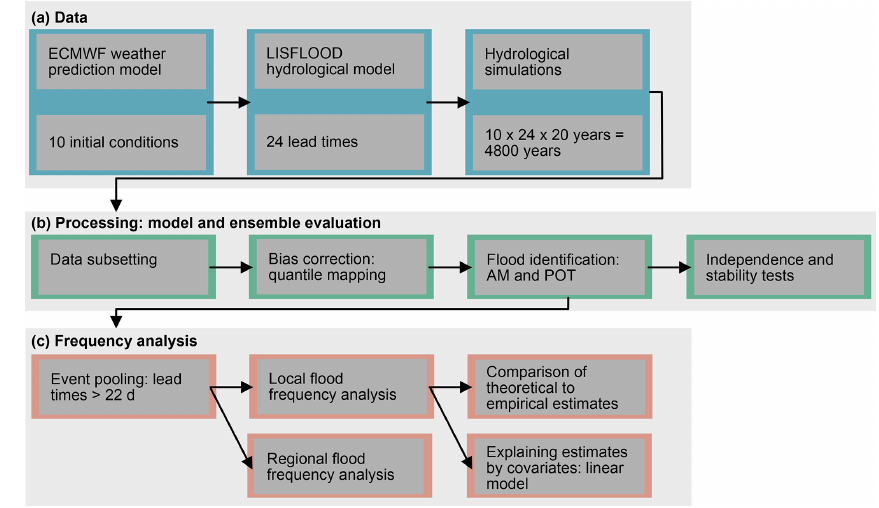
Figure 1. Illustration of workflow. (a) Data set derivation from a weather prediction–hydrological model chain. (b) Data processing through model and ensemble evaluation. (c) Local and regional frequency analysis by pooling flood events across lead times. AM is the annual maxima, and POT is the peak over threshold approach.